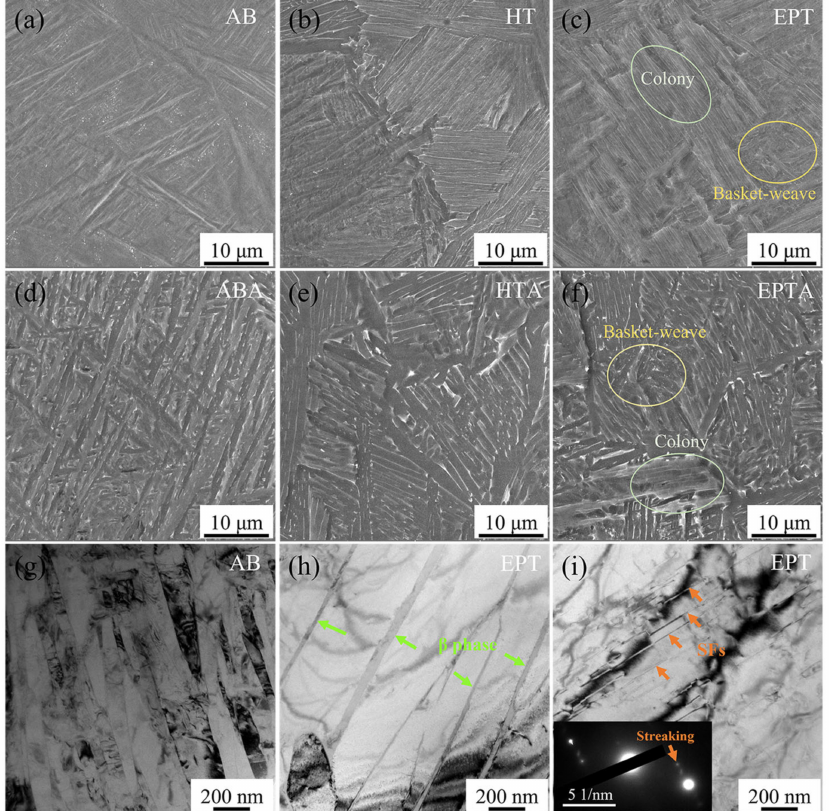
Figure 2. Backscattered SEM micrographs of samples before and after the stabilization